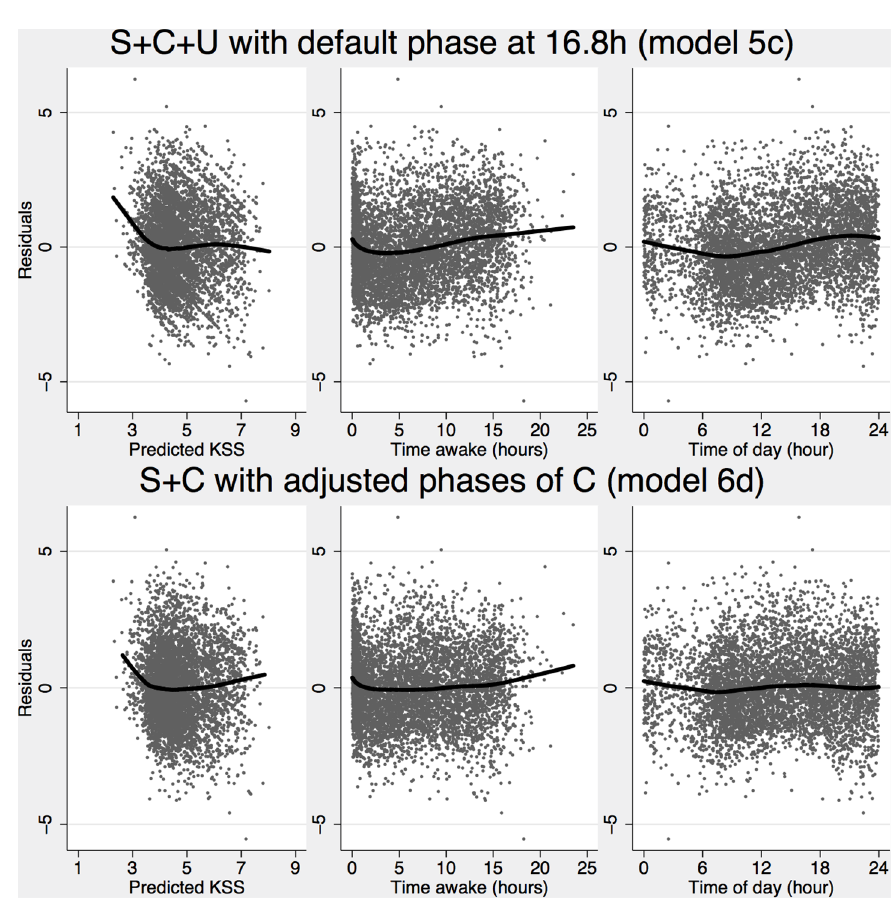
Figure 3. Residuals (observed ratings-predicted sleepiness) plotted against predicted KSS (left), time awake (middle) and time of day (right) for the best model with assumed default phase of C (model 5c, top) and circadian type adjusted phases of C T (model 6d, bottom) with a LOWESS line indicating potential systematic bias in predictions.